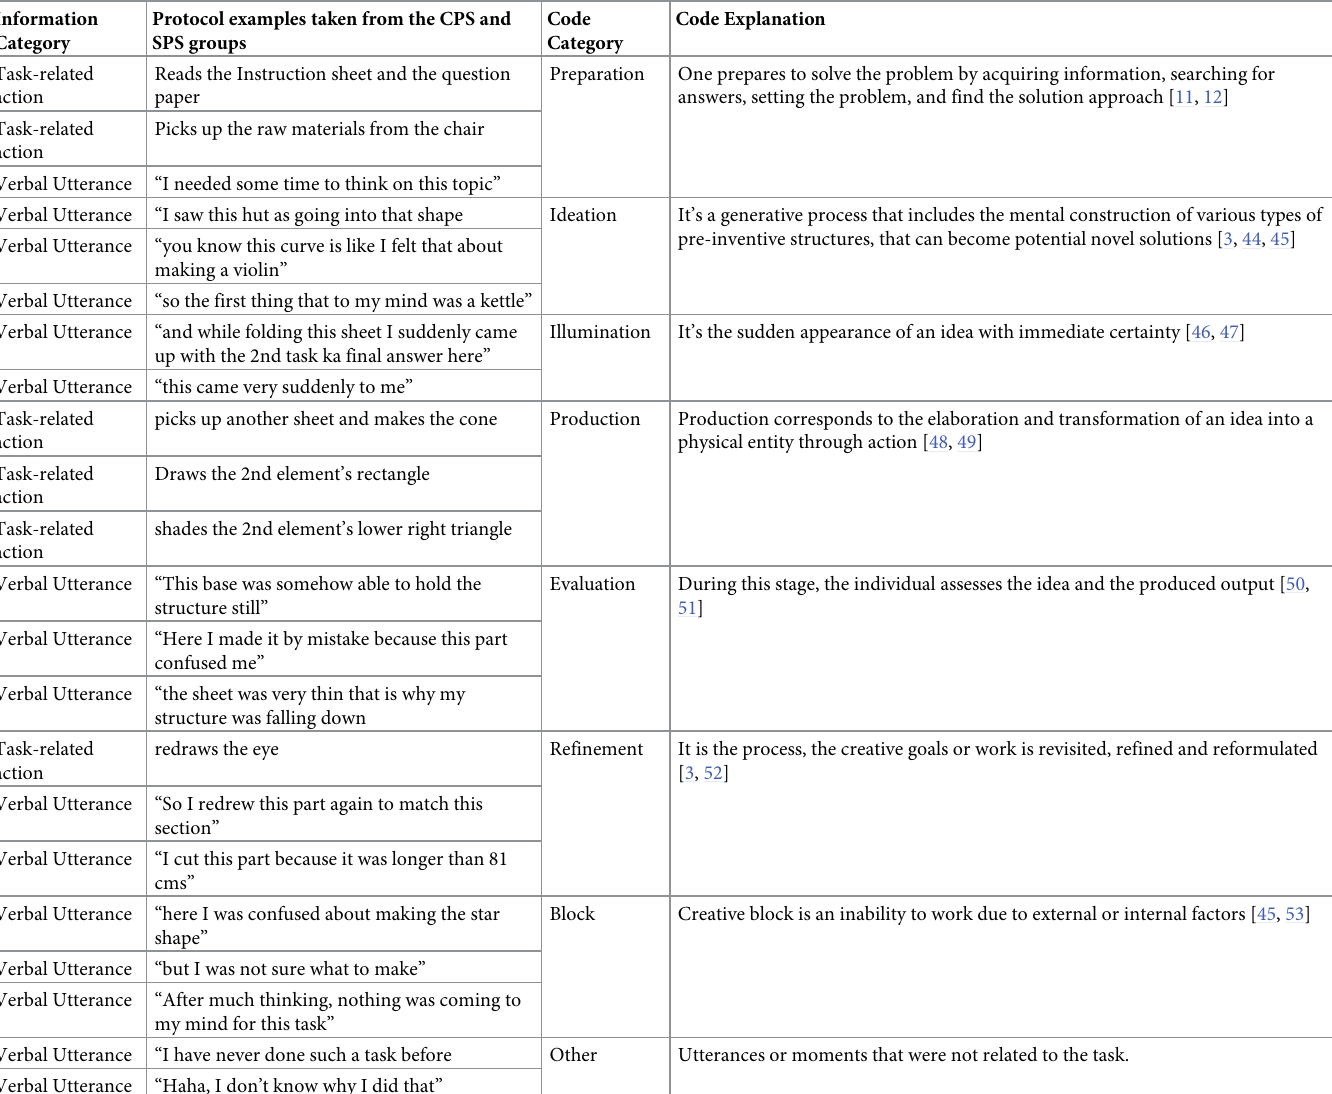
Table 1. Details of information category, example segments, and code explanation from participants’ protocols, all coded into seven stages. Information